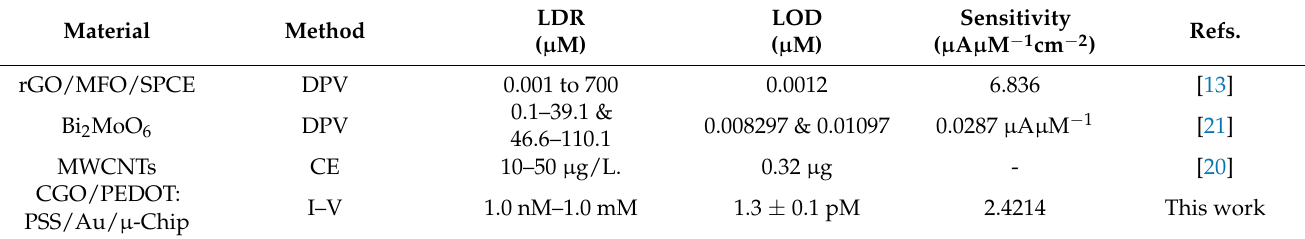
Table 2. Comparison of different electrochemical processes for specific 4-CP